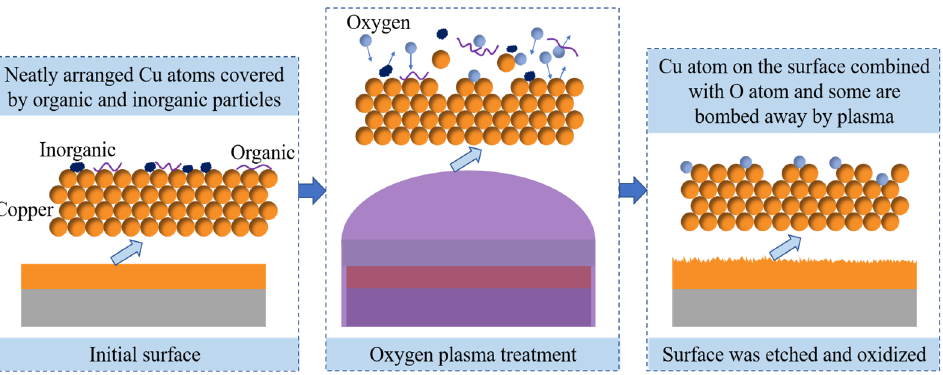
Figure 6. Physicochemical change form of interface during oxygen plasma treatment.